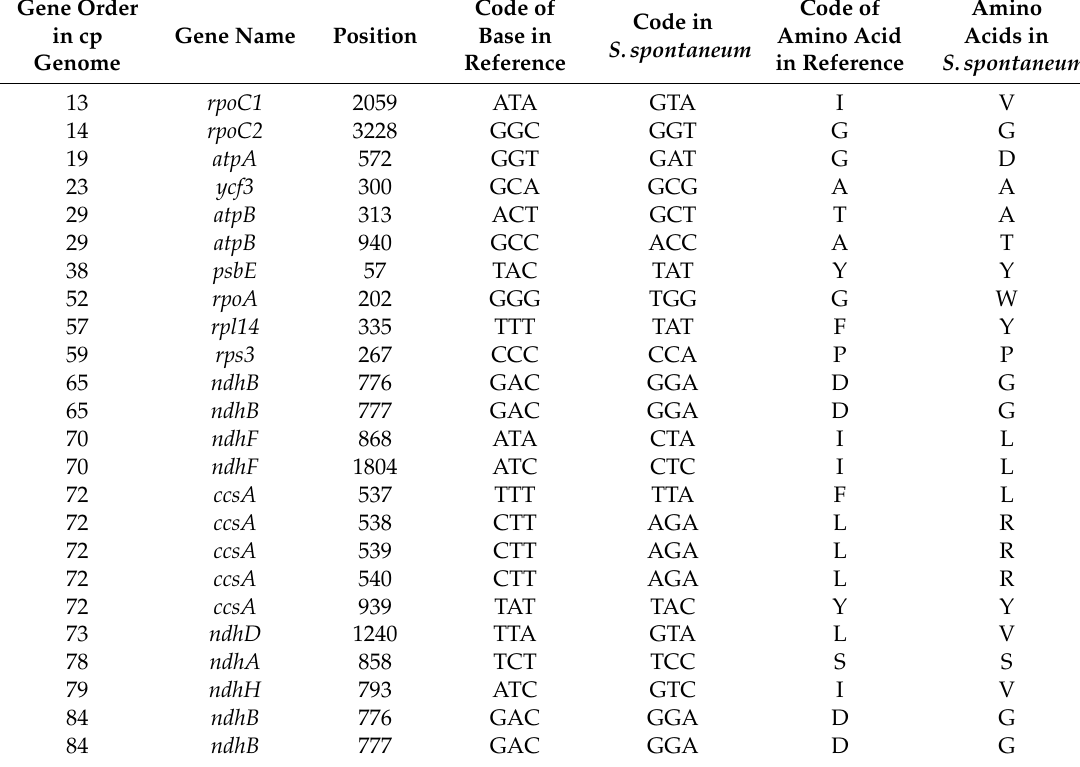
Table 2. SNP loci identified in Saccharum spontaneum reference to S. o ffi cinarum .